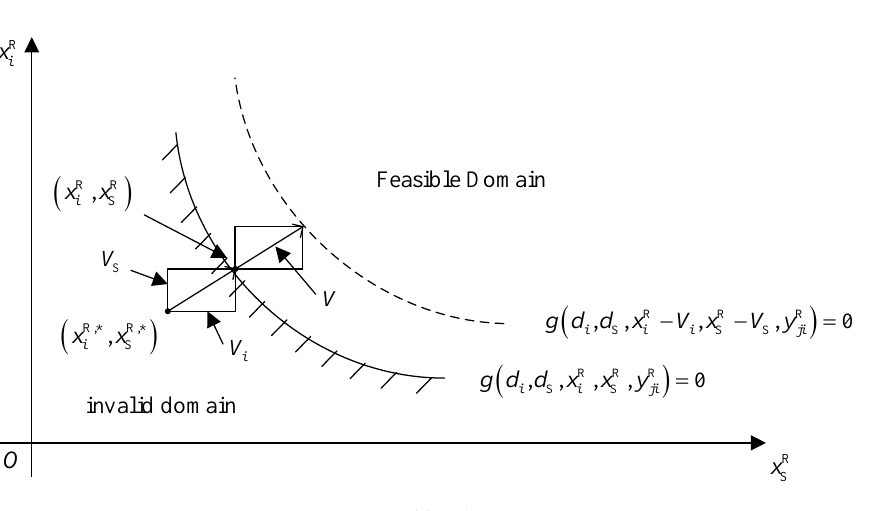
Figure 2. Movement constraints constructed by the movement vectors.